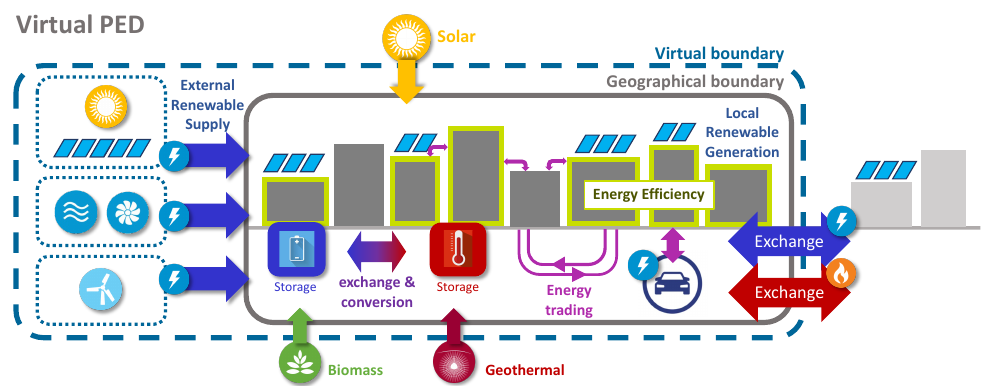
Figure 3. Virtual PED, principle and system boundaries. Including virtual integration of external renewables and exchange with the surrounding systems. Including energy efficiency measures, renewables (solar, PV, wind, biomass, geothermal, small hydropower), waste heat recovery, electric and thermal storage, integration of mobility energy needs (and EVs as batteries), sector coupling between electric and thermal, and exchange with the surrounding